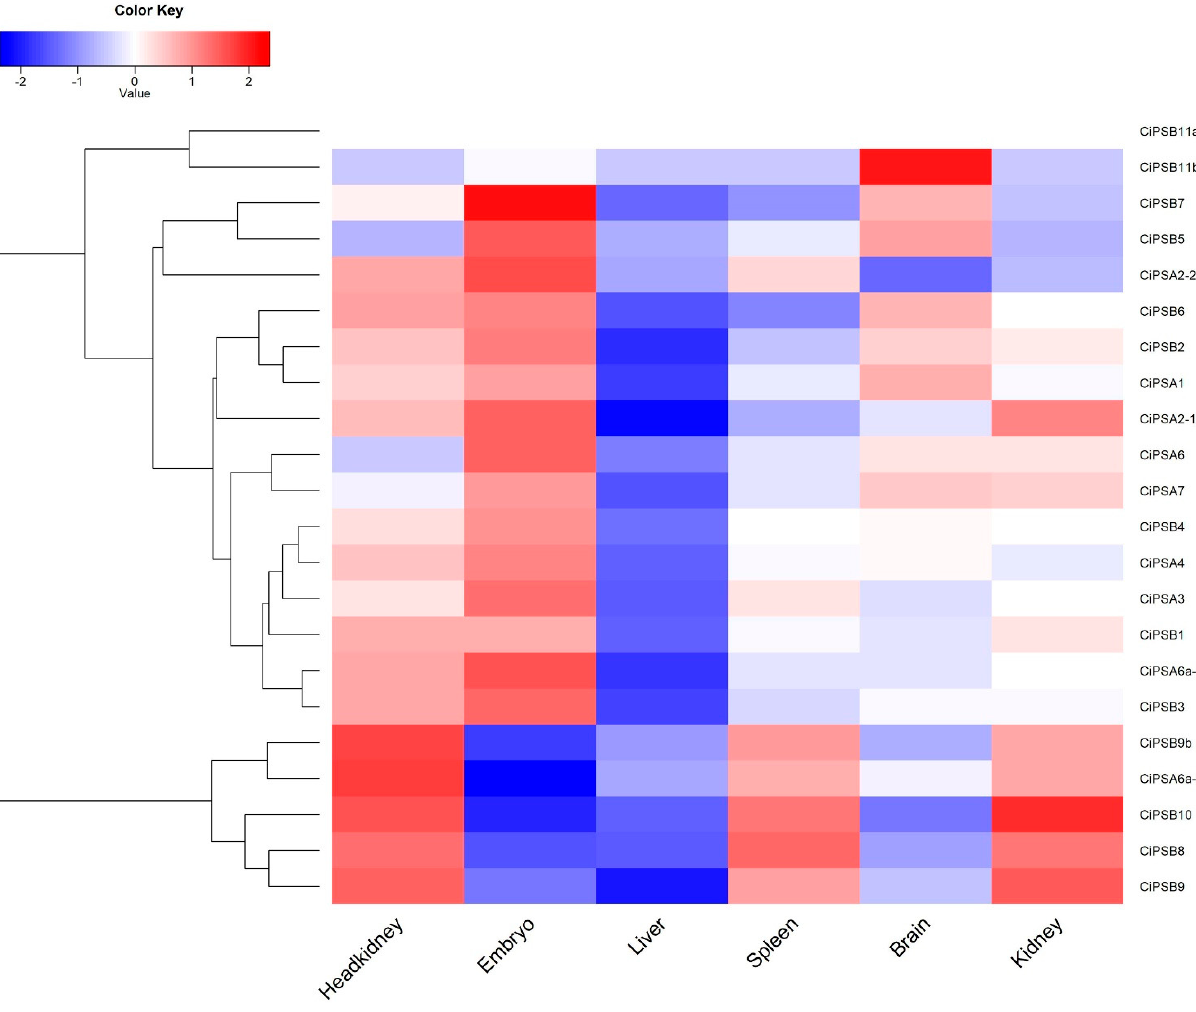
Figure 6. Expression profile of CiPS gene family members in six tissues of grass carp. In the high-density culture stress test, juvenile grass carp (n = 400, 31.3 ± 7.3 g) were collected from the Jiangsu grass carp breeding center and randomly distributed in circulating tanks for domestication for 14 days. A net was placed in the tank to regulate stock density, and the fish were randomly divided into two groups: simulated intensive farming high density (40 kg m − 3 ) and extensive farming low density (3 kg m − 3 ). CiPS genes were highly expressed in muscle with low density versus high density, and some of the CiPS members were also expressed in the brain and the intestine in response to the high stocking density. Most notably, the CiPSB genes on the chromosome segment CI01000319 (including CiPSB9, CiPSB9b, CiPSB10, and CiPSB8) were consistently expressed, showing a group (Figure 7). The expression levels of each CiPS gene family member can be referred to in Supplementary Material